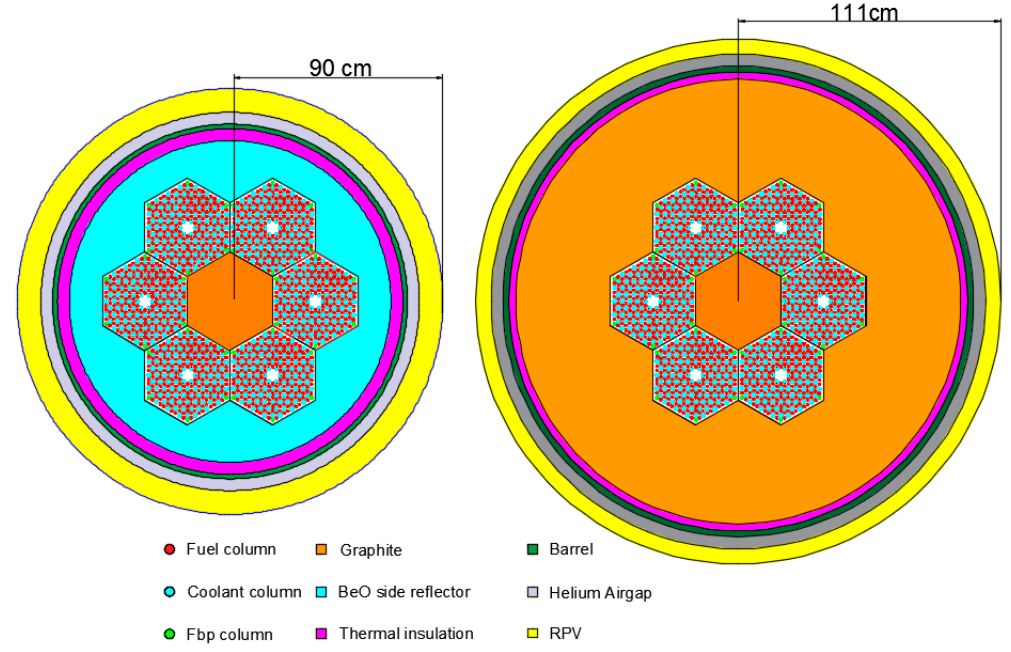
Figure 2. The original ( left ) and the modified graphite ( right ) U-Battery design used in this